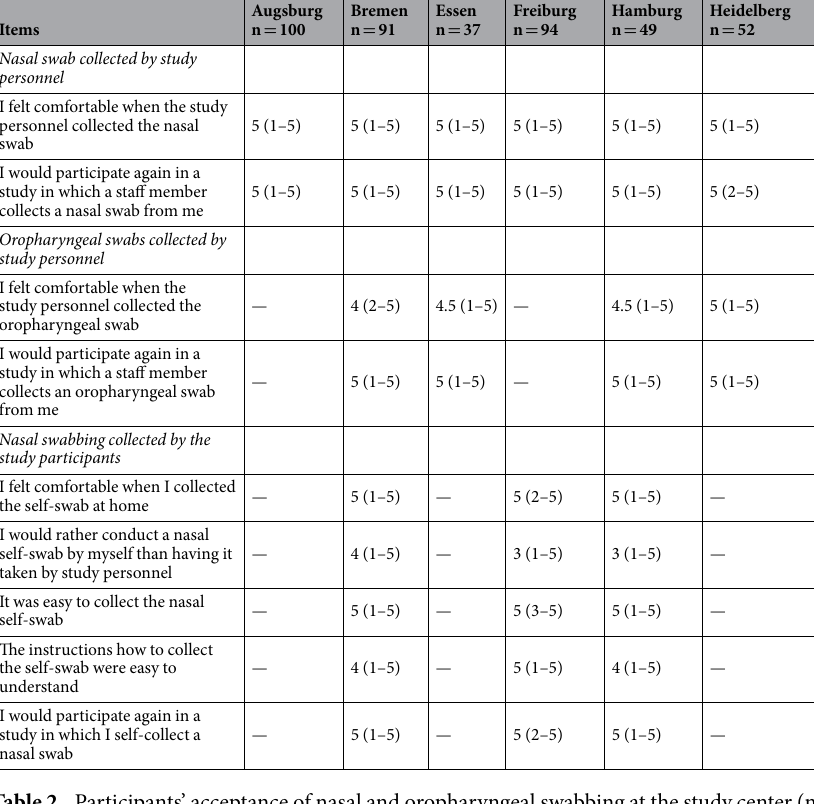
5 Scientific RepoRts | 7: 1855 | DOI:10.1038/s41598-017-01212-6